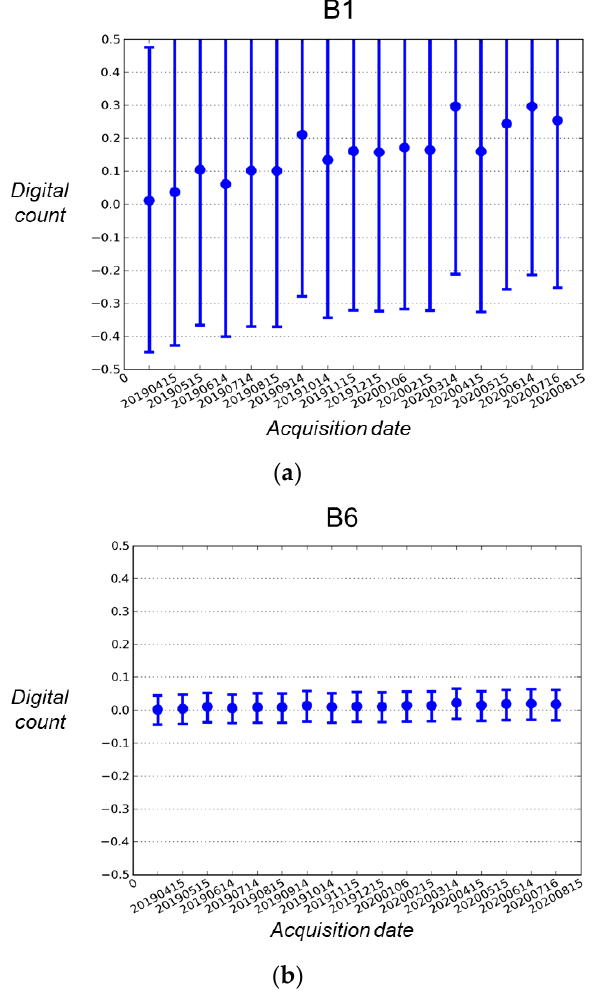
Figure 5. ( a ) Dark difference (in DC) between computed coefficients and operational ones during about 1 year for B1 spectral band; ( b ) same results for B6 spectral band.